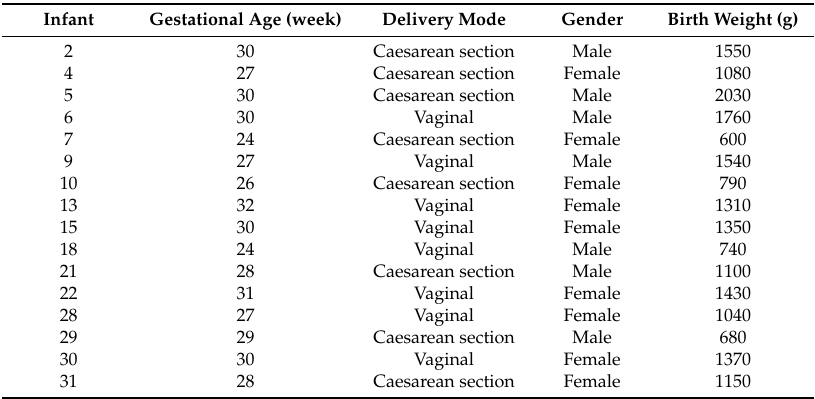
Table 1. Demographic data for the infant